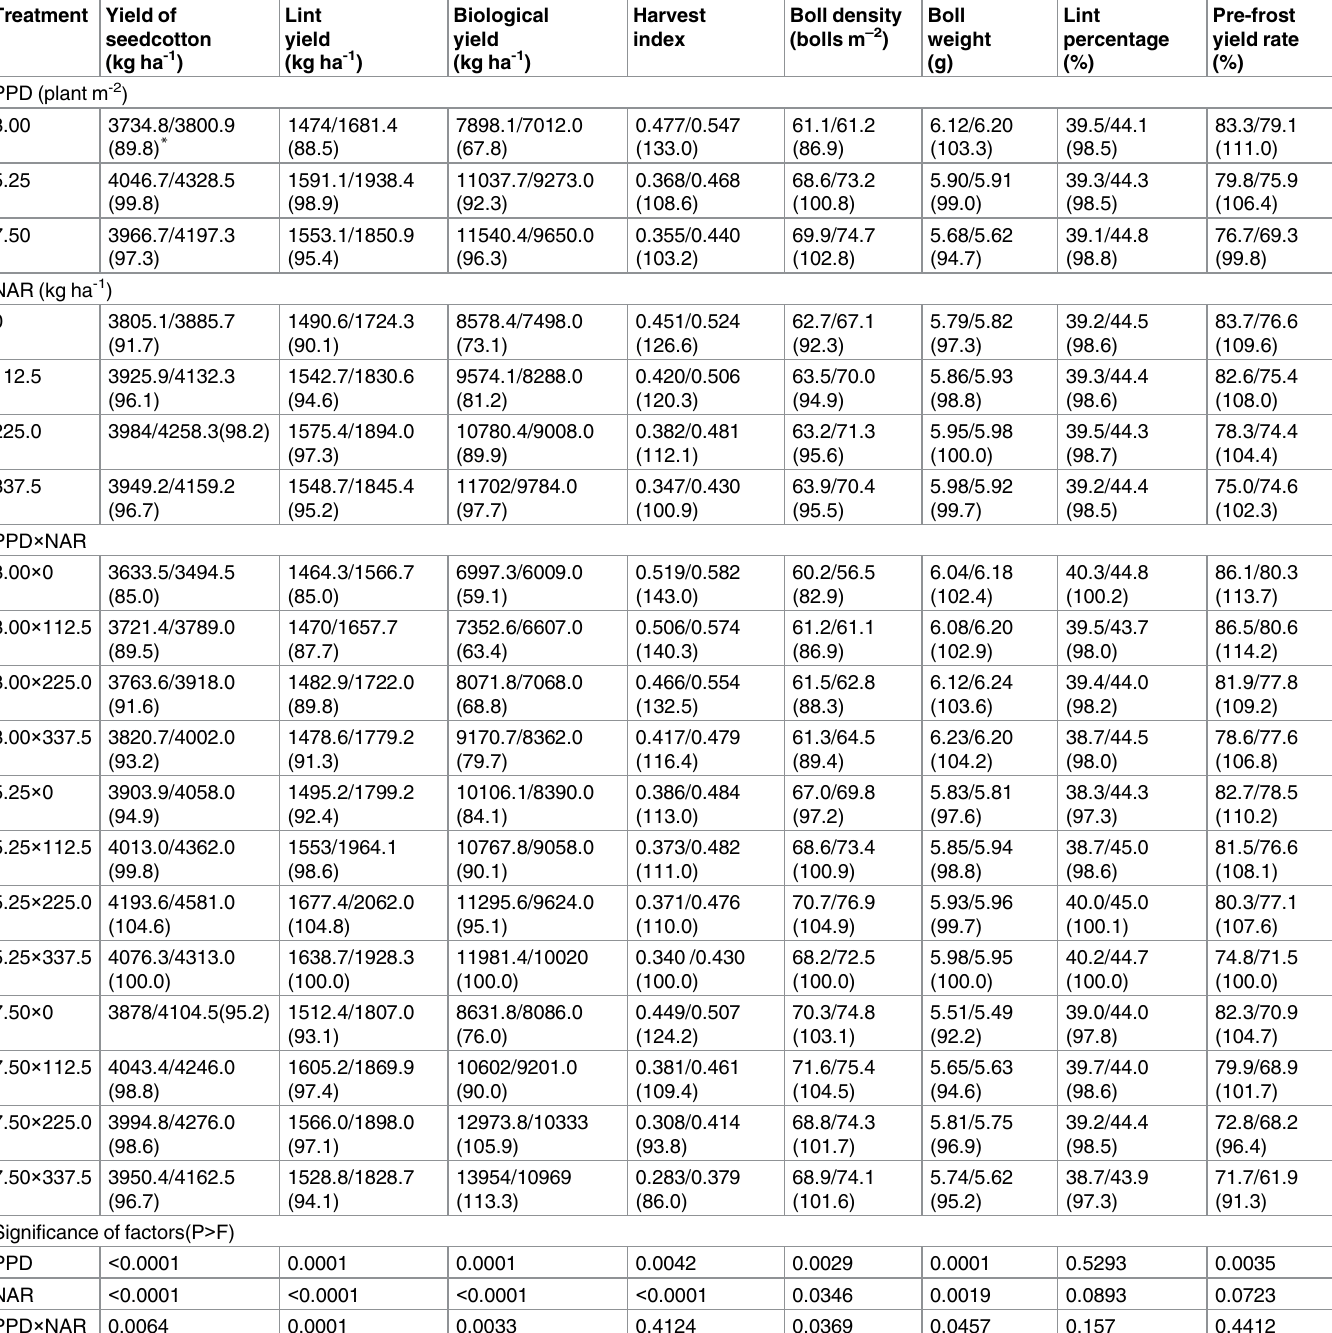
Table 3. Effects of PPD and NAR on biological, economic (seedcotton and lint) yield and harvestindex in 2013 and 2014. Treatment Yield of